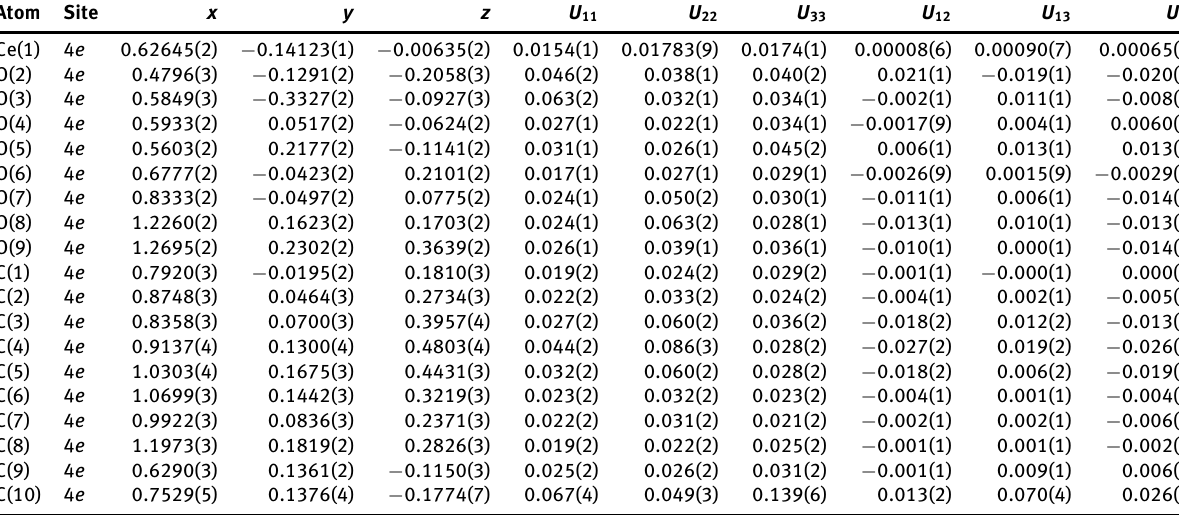
Table 3: Atomic displacement parameters (Å 2